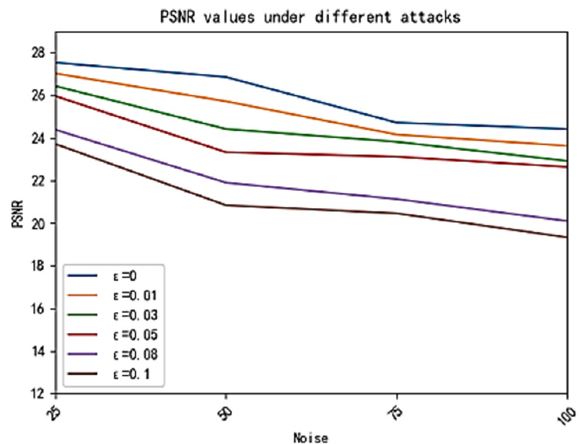
Figure 7. PSNR values under different levels of FGSM attacks.